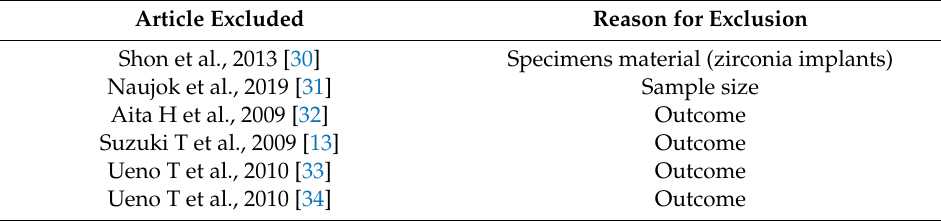
Table A1. Table reporting the excluded studies and reasons for